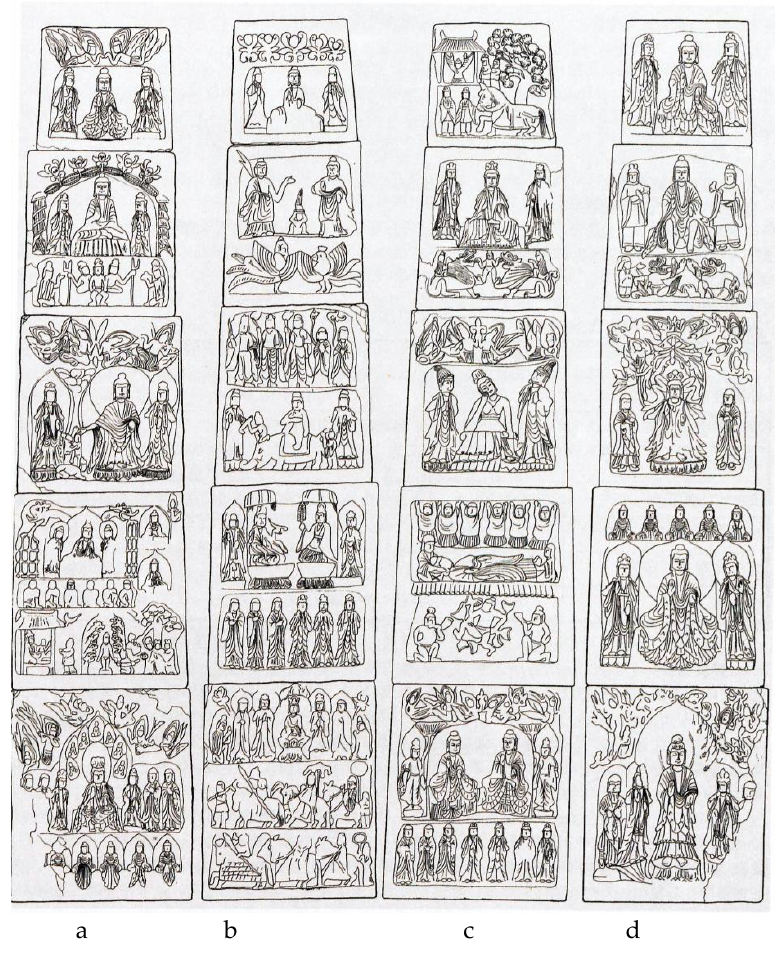
Figure 9. ( a – d ) Five-story Pagoda from Baoquansi, Zhuanglang, Gansu province. Early sixth century, Northern Wei. Stone. H. ~45 cm, W. 28–34 cm. Gansu Provincial Museum. Reprinted with permission from ref. [Gansu fojiao shike zaoxiang]. 2000, Zhang Baoxi, p. 25.